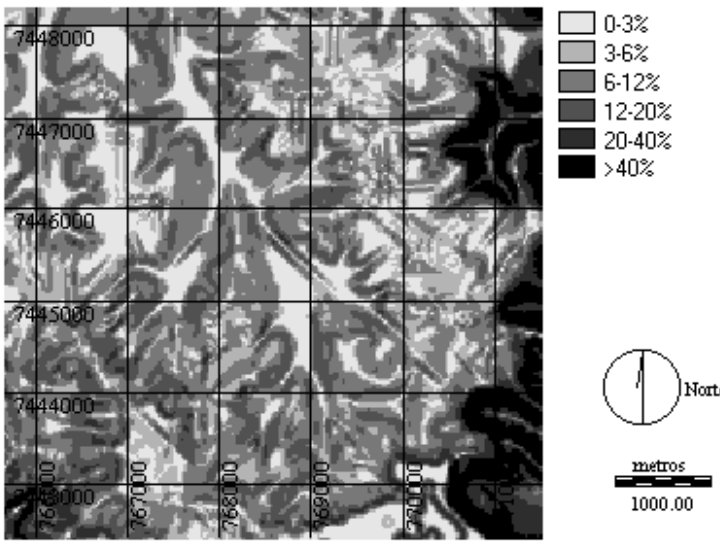
Figura 2. Mapa de classes de